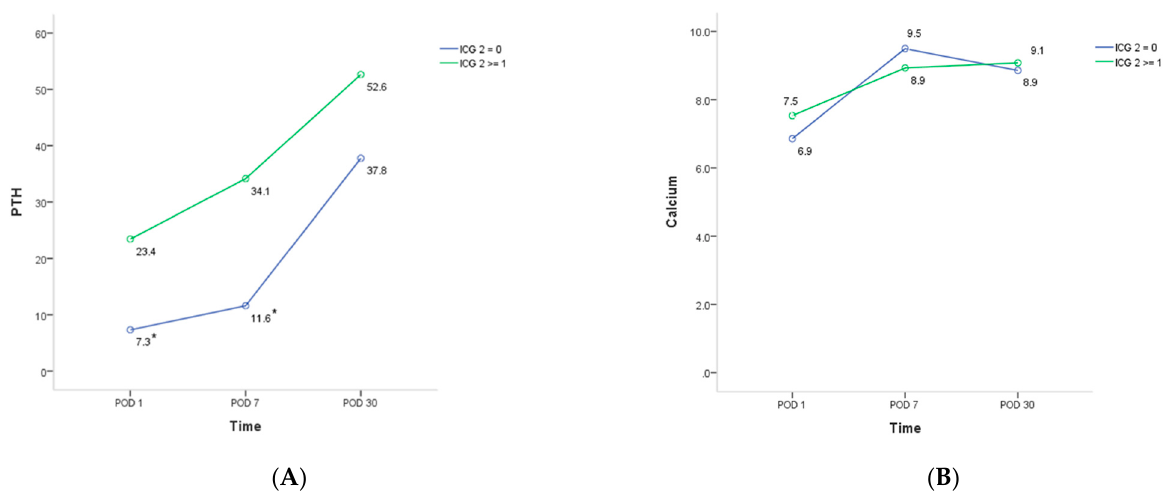
Figure 2. Mean postoperative parathyroid hormone ( A ) and calcium ( B ) levels in patients who underwent total thyroidectomy with or without at least one well-perfused parathyroid gland. Patients who had at least one well-perfused parathyroid gland (ICG 2 ≥ 1) show significantly higher parathyroid hormone level on postoperative day one (POD 1) and after one week (POD 7) than those who had no well-perfused parathyroid gland (ICG 2 = 0) ( A ). The calcium level on postoperative day one is also higher in patients with at least one well-perfused parathyroid gland (ICG 2 ≥ 1), but without statistical significance ( B ). ICG 2, Indocyanine green score 2; POD, Postoperative day; PTH, parathyroid hormone. * statistically significant difference when compared between the two groups ( p < 0.05).